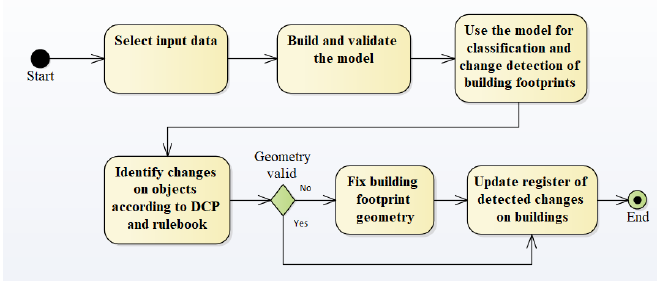
Figure 3. The overview of the proposed methodology.